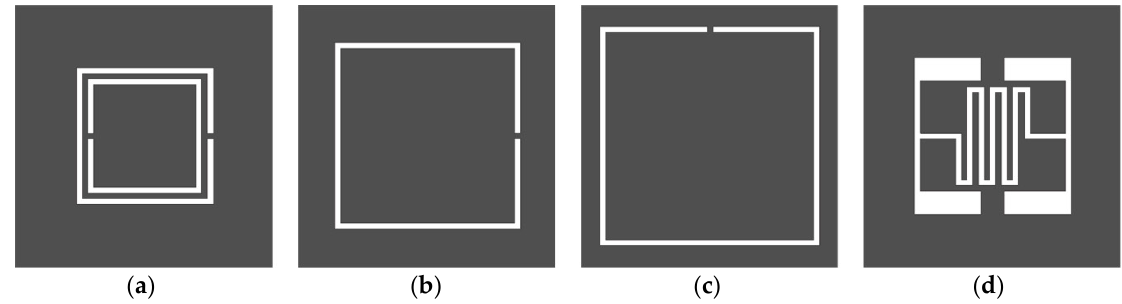
Figure 1. Four different resonator shapes considered for sensitivity comparison: ( a ) double-ring complementary split ring resonator (DR-CSRR); ( b ) single-ring complementary split ring resonator (SR-CSRR); ( c ) rotated single-ring complementary split ring resonator (R-SR-CSRR); ( d ) interdigital-capacitor-shaped defected ground structure (IDCS-DGS).